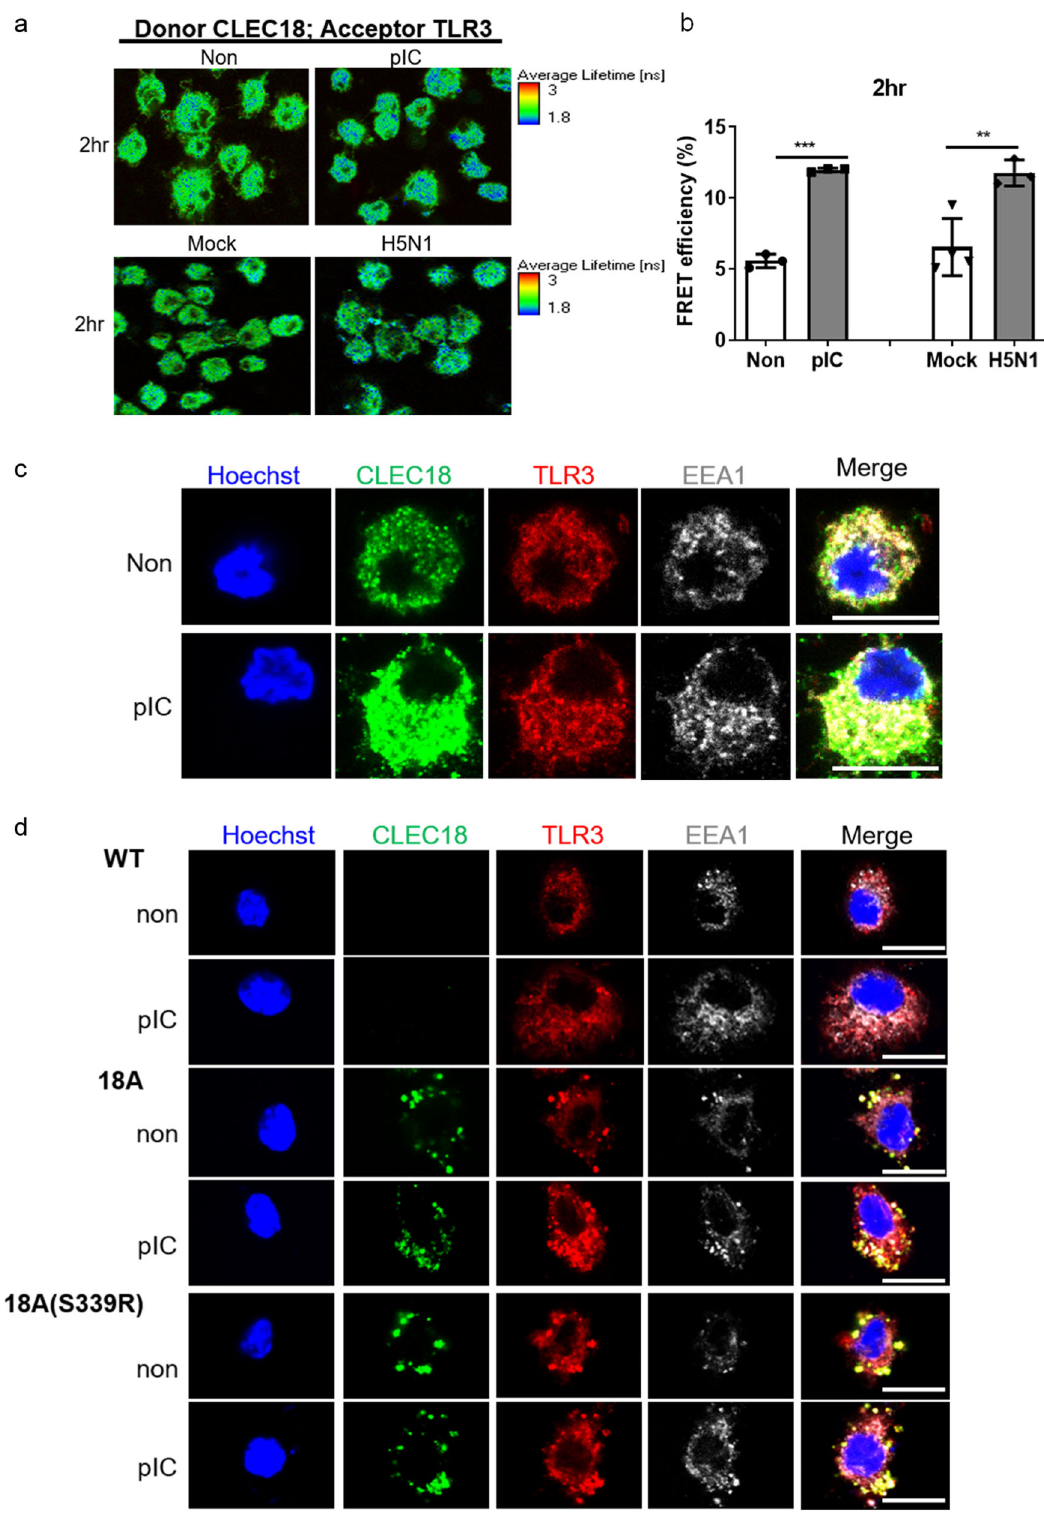
CLEC18A and ROSA- CLEC18A(S339R) mice after H5N1 IAV tically in CLEC18A(S339R) mice (Fig. 8d), and the expression of viral M and NP mRNAs is downregulated in ROSA-CLEC18A and ROSA-CLEC18A(S339R) mice at day 7 post infection (Fig. 8e). We further investigate the cytokine amount in bronchoalveolar lavage fl uid (BALF) by enzyme-linked